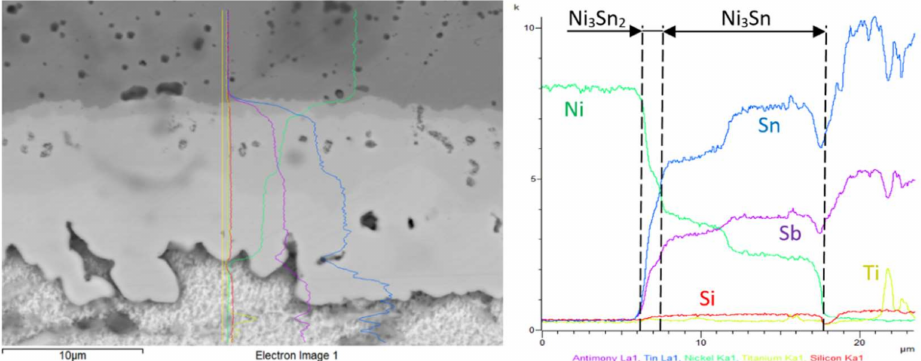
Figure 18. Concentration profiles of Ni, Sn, Sb and Ti elements in the boundary of Ni/Sn5Sb3Ti joint.